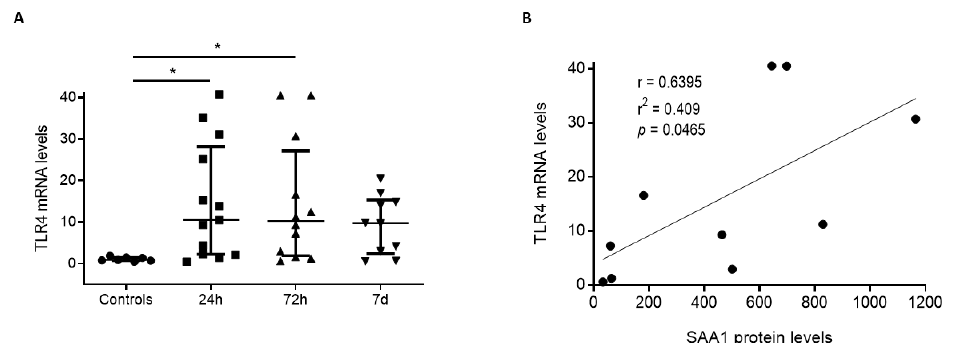
Figure 3. TLR4 mRNA levels increase in circulating leucocytes during the first week after trauma and determination at 72 h positively correlates with SAA1 serum levels. ( A ) Q-PCR determined that TLR4 mRNA levels of circulating blood cells significantly increase at 24 h (n = 13) and 72 h (n = 11) in trauma patients compared to controls (n = 7). At 7 days (n = 10), there were no significant differences. * p < 0.05, 1-way ANOVA with Dunnett’s multiple comparisons test. ( B ) A correlation analysis (10 patients) between TLR4 mRNA of blood cells and SAA1 serum levels at 72 h was determined. The correlation coefficient (r = 0.6395) detected a positive correlation between the variables. In the correlation analysis test, p < 0.05 was established to determine a true correlation. Data of all experiments are represented as median with interquartile